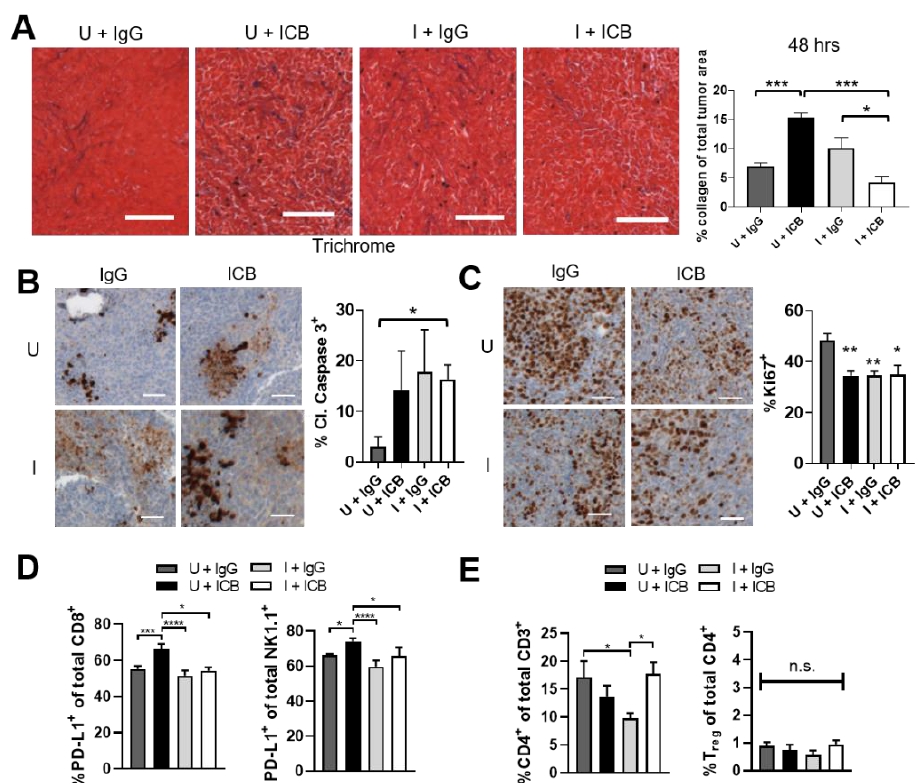
Figure 6. ST-SOT with immune checkpoint blockade (ICB) treatment augments tumor cell apoptosis, prevents increased expression of PD-L1 associated with ICB, and preserves CD4 populations associated with collagen degradation. C57BL/6 mice bearing s.c. Pan02 tumors (average 100 mm 3 , n = 3–5) were i.v. administered ST-SOT (5 × 10 6 CFU) and then i.p. administered 250 mg L-arabinose (induced, I) or PBS (uninduced, U). At induction/PBS, mice were i.p. administered immune checkpoint blockade (ICB) antibodies (anti-PD-1 (200 µg) + anti-CTLA-4 (75 µg)) or control IgG antibody. Forty-eight hours later tumors were excised and processed for sectioning and flow cytometry. ( A ) Tumors were sectioned, stained using Masson’s trichrome method, and analyzed for collagen density (representative images shown, scale bar = 100 µm). Bar graph represents whole tumor quantification of collagen stain out of total tumor area ( n = 3). * p < 0.05, *** p < 0.001, t -test. Sectioned tumors were stained for IHC with anti-cleaved caspase 3 antibody (brown) ( B ) or anti-Ki67 antibody (brown) ( C ). Nuclei were counterstained with hematoxylin (blue) (representative images are shown, scale bar = 50 µm). Bar graphs represent whole tumor quantification of positive cells out of total nuclei. * p < 0.05, ** p < 0.01, t -test. ( D ) Tumors processed for flow cytometry were analyzed for PD-L1-expressing immune subsets and ( E ) CD4 + CD25 + FoxP3 + cells (Tregs). * p < 0.05, *** p < 0.001, **** p < 0.0001, t -test.